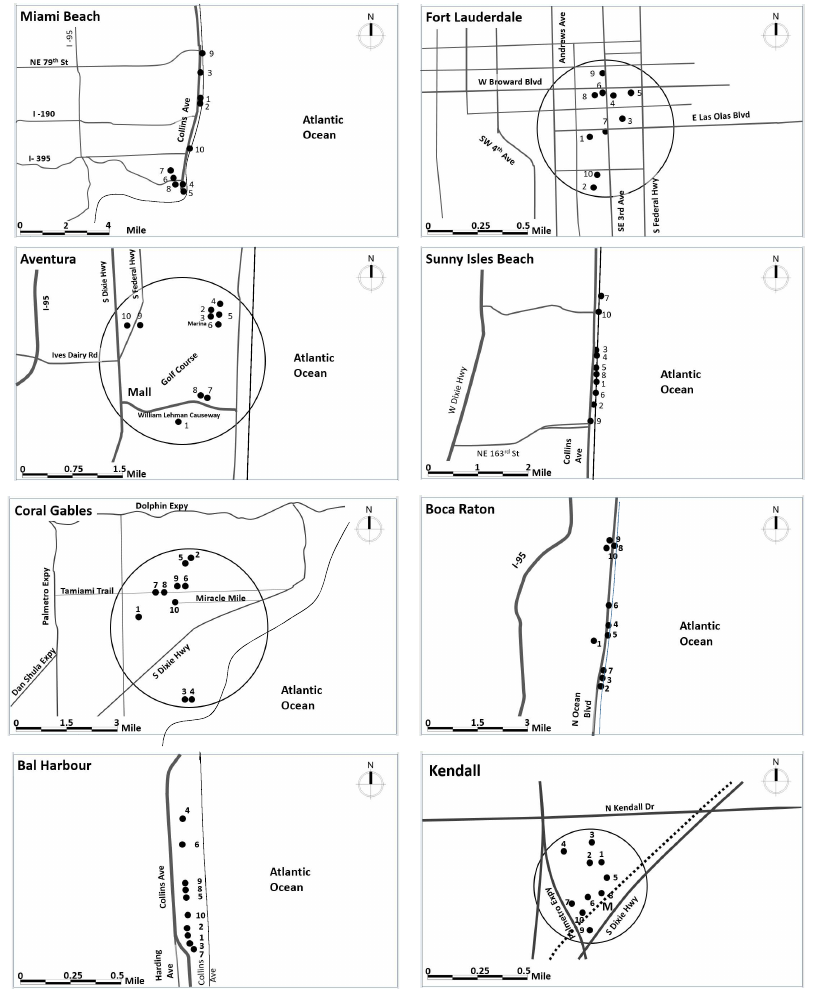
Figure 4. Spatial patterns of tall buildings in suburban communities of Miami Metropolitan Area. Each map shows the locations of the ten tallest buildings in its respective